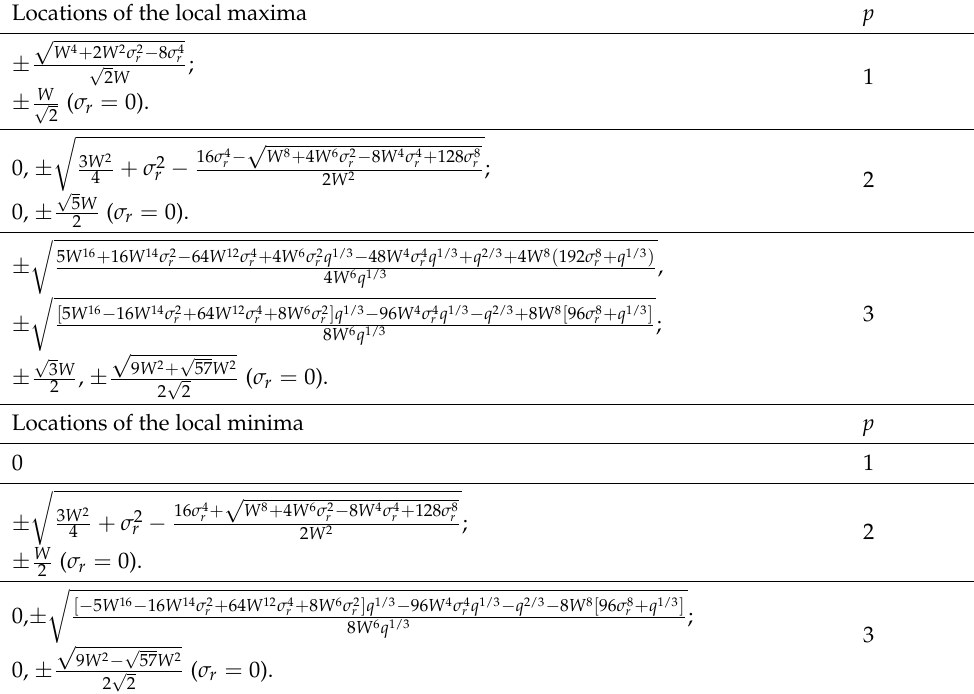
Table 3. Locations of local maxima and minima value in the average irradiance under pointing error. Locations of the local maxima